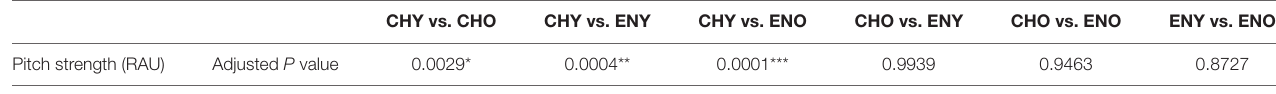
TABLE 1 | Post hoc group comparisons on pitch strength in RAU. CHY vs. CHO CHY vs. ENY CHY vs. ENO CHO vs. ENY CHO vs.